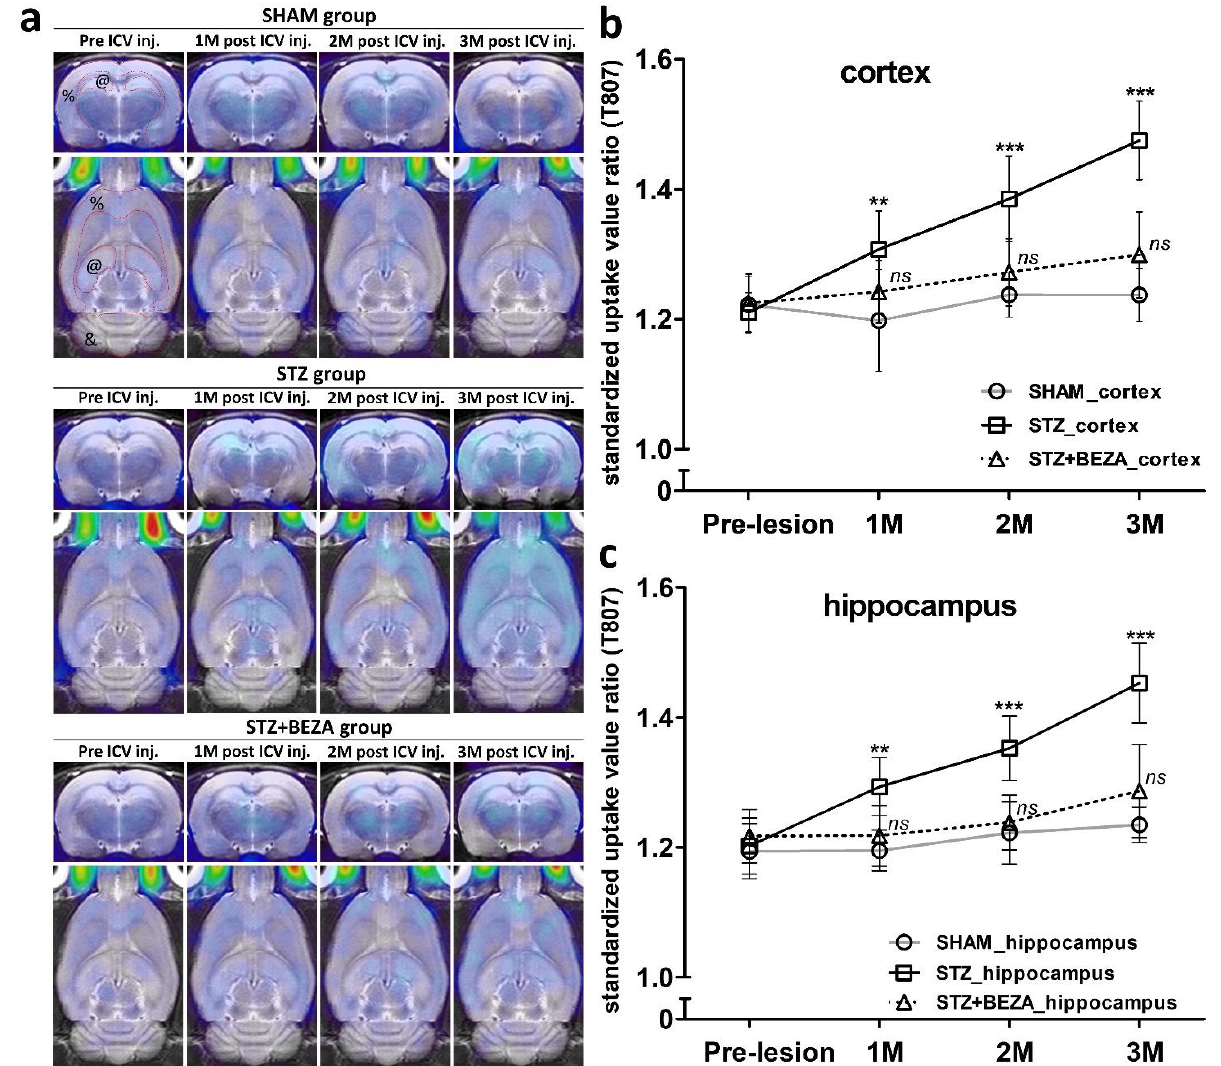
Figure 3. Bezafibrate attenuated PHF-tau accumulation in STZ-ICV-injected rats. Animal PET with T807 was used for the in-vivo measurement of PHF-tau accumulation. After STZ-ICV administration, the cerebral T807 uptake was gradually increased in the STZ group, but only minimally increased in the SHAM and STZ+BEZA groups ( a ). Quantitative analysis of T807 uptake revealed that STZ-ICV administration caused a progressive and significant increase in SUVRs in the cortex ( b ) and hippocampus ( c ) in the STZ group. Bezafibrate treatment successfully attenuated STZ-ICV-induced PHF-tau accumulation, as there was no significant difference in SUVRs between the STZ+BEZA and SHAM groups until the third month. Red dotted lines indicate representative delineation of cortex [%], hippocampus [@], and cerebellum [&]. Data are presented as mean ± SD; **, p < 0.01, ***, p < 0.001, ns , not significant, vs. SHAM group at the same time point; n = 6, per group.